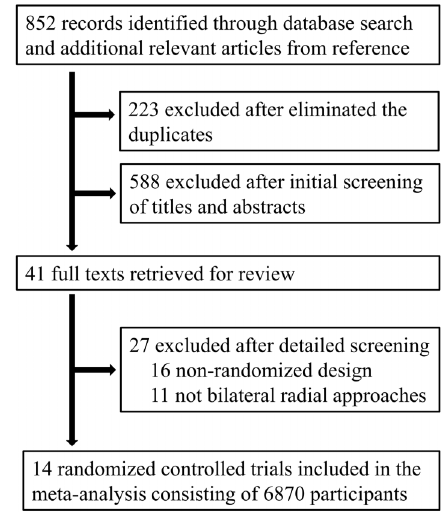
Figure 1. Flowchart of study